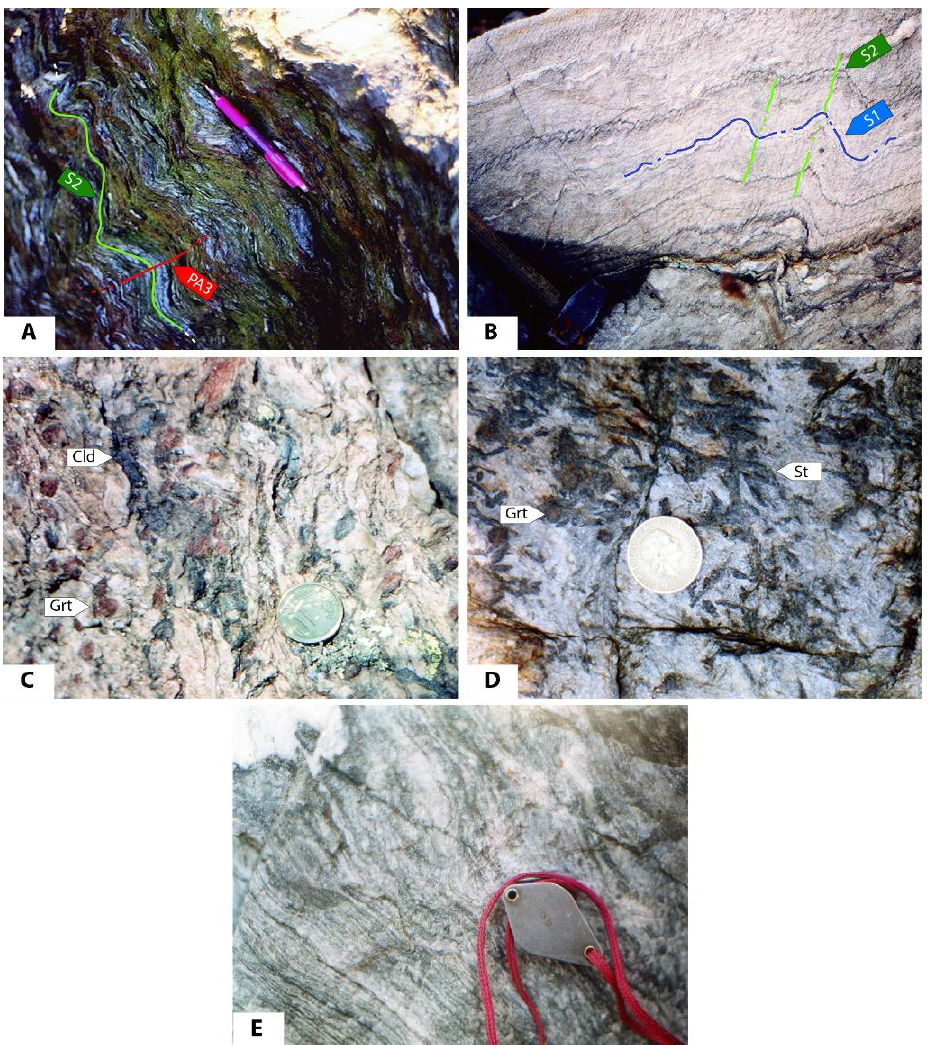
Figure 4. Mesoscale representative structures and mineral assemblages in the Sellero–Cedegolo basement. Metapelites: ( A ) Alpine D3 folding overprints Variscan S2 foliation marked by greenschist facies minerals. D3 axial plane dips to NW; ( B ) overprinting relationships between S1 and S2. S2 dips to S; ( C ) garnet (Grt) and chloritoid (Cld) grains supporting S1a foliation; ( D ) aggregates of staurolite (St) grains lying with garnet (Grt) on S1b foliation. Metagranitoids: ( E ) mylonitic S2 marked by chlorite and white mica. The red line is the lens lanyard, here used as scale.